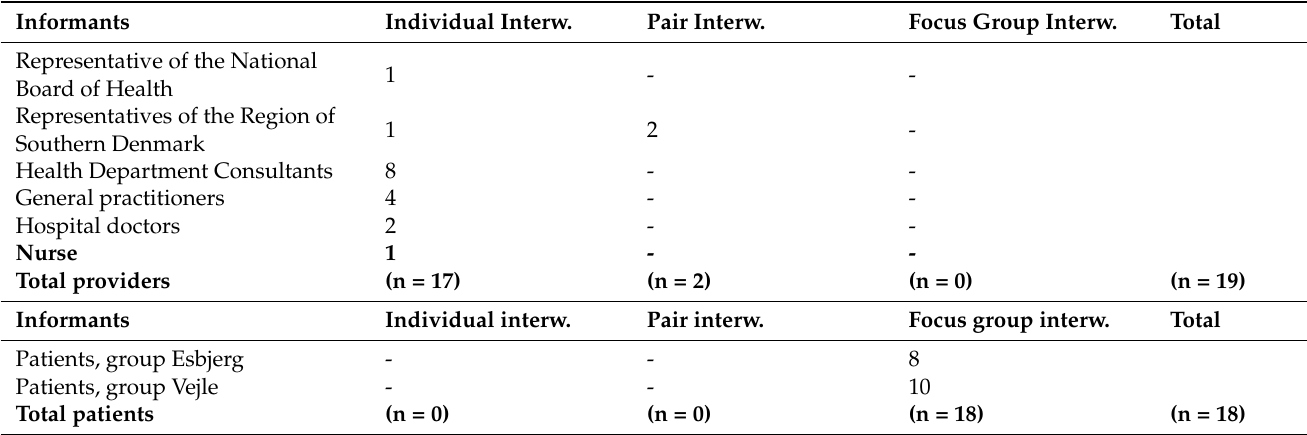
Table 1. Number of individuals in different types of